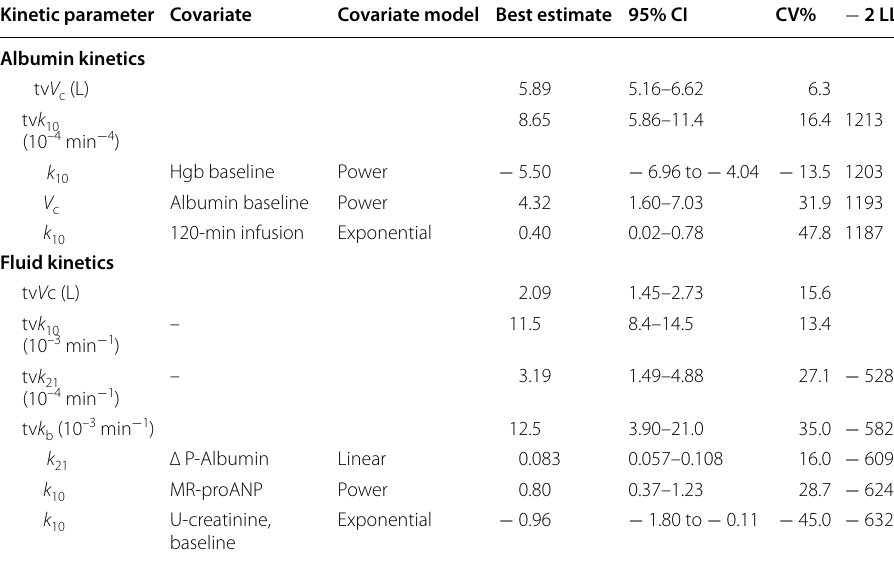
Shown are the typical values (tv) for the fixed parameters in the group, followed by individual‑specific covariates tv typical value for the group. CI = Mean blood Hgb at baseline 137 g/L and mean plasma albumin 40.0 g/L LL log likelihood for the model during development. Decrease by > 3.8 points =